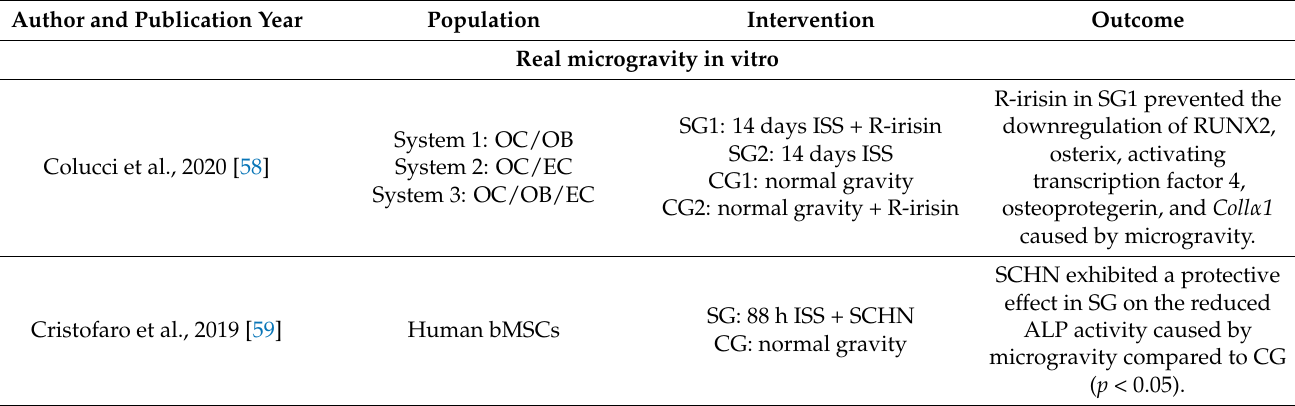
Table 2. Possible CMs for µ g -induced bone loss and their